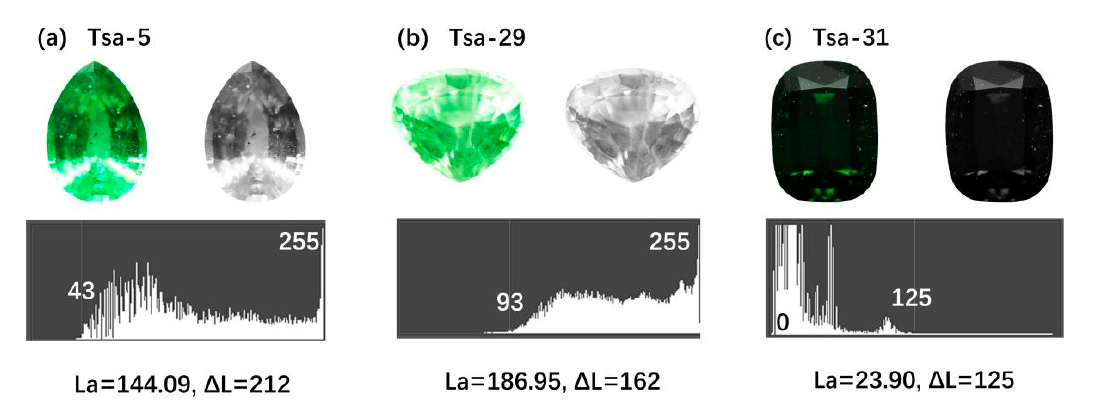
Figure 13. Analysis of the scintillation of three gem samples (Tsa-5, Tsa-29, Tsa-31). The top is the sample photo and the sample photo excluding saturation, and the bottom is a luminance histogram of the sample excluding saturation. The bigger the ∆ L, the stronger the flicker. Gem scintillation from strong to weak is: ( a ) > ( b ) > ( c ).